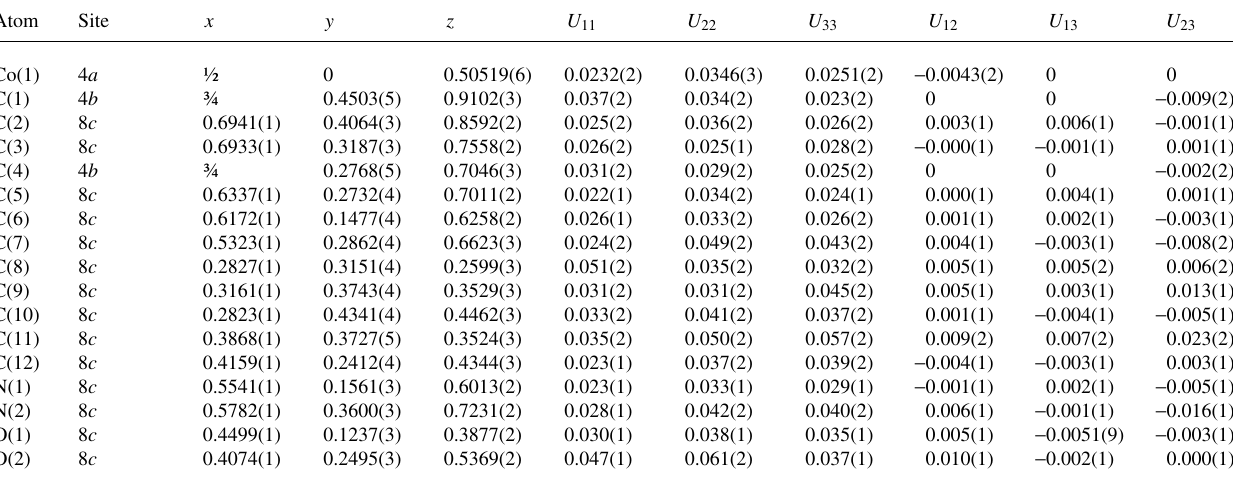
Table 3. Atomic coordinates and displacement parameters (in Å 2 )